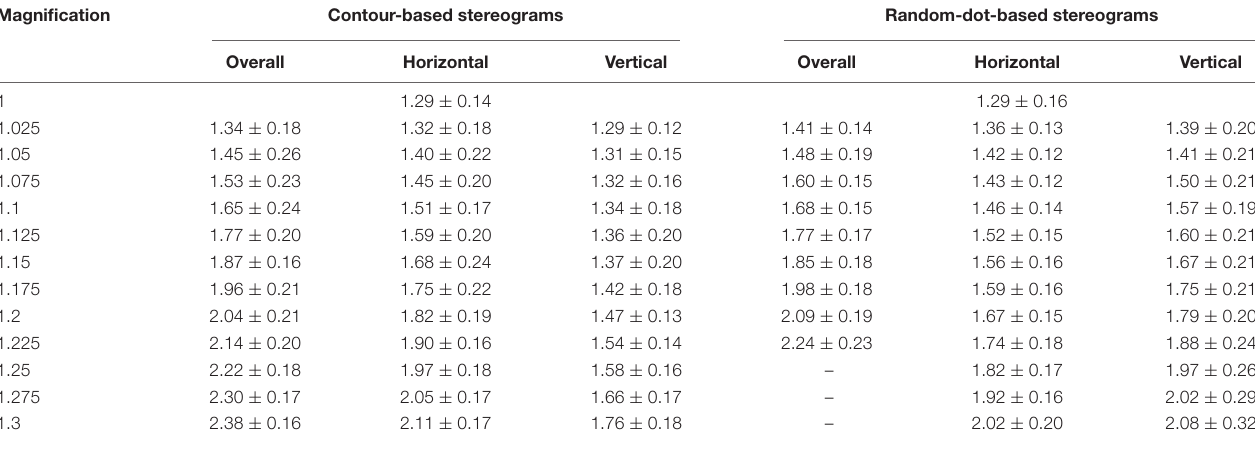
TABLE 1 | Mean ± SD of stereopsis values (log arcsec) tested under different conditions of aniseikonia.